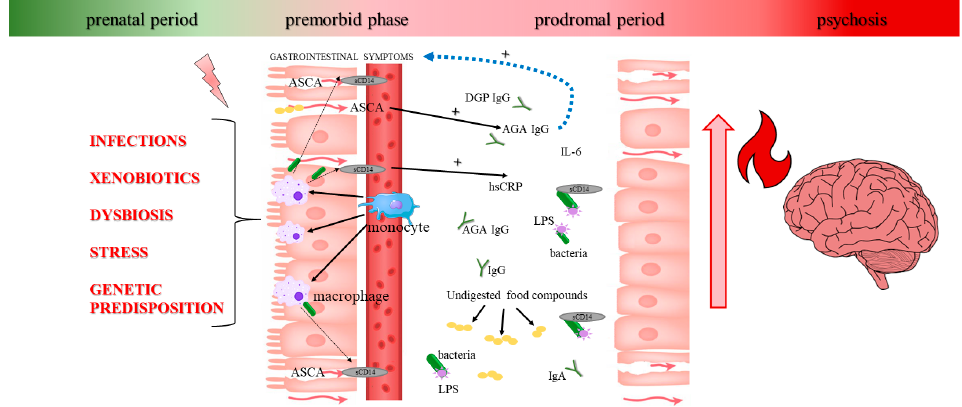
Figure 1. The interplay between genetic susceptibility and environmental factors across prenatal and early life may lead to intestinal hyperpermeability via immune activation. Through the production of intestine-related proteins (sCD14 and ASCA), undigested gluten-derived compounds trigger an immune–inflammatory response (secretion of AGA and CRP) disproportionate to the amount of gluten intake. High levels of IgG AGA antibodies provoke gastrointestinal manifestations. There is a conversion of gliadin antibodies produced (from the subclass IgG to IgA) during the disease course.